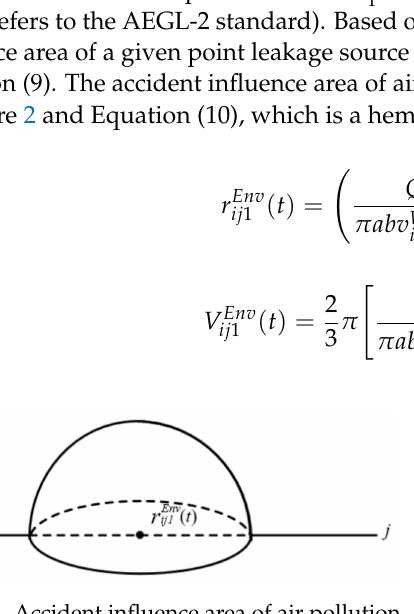
Figure 2. Accident influence area of air